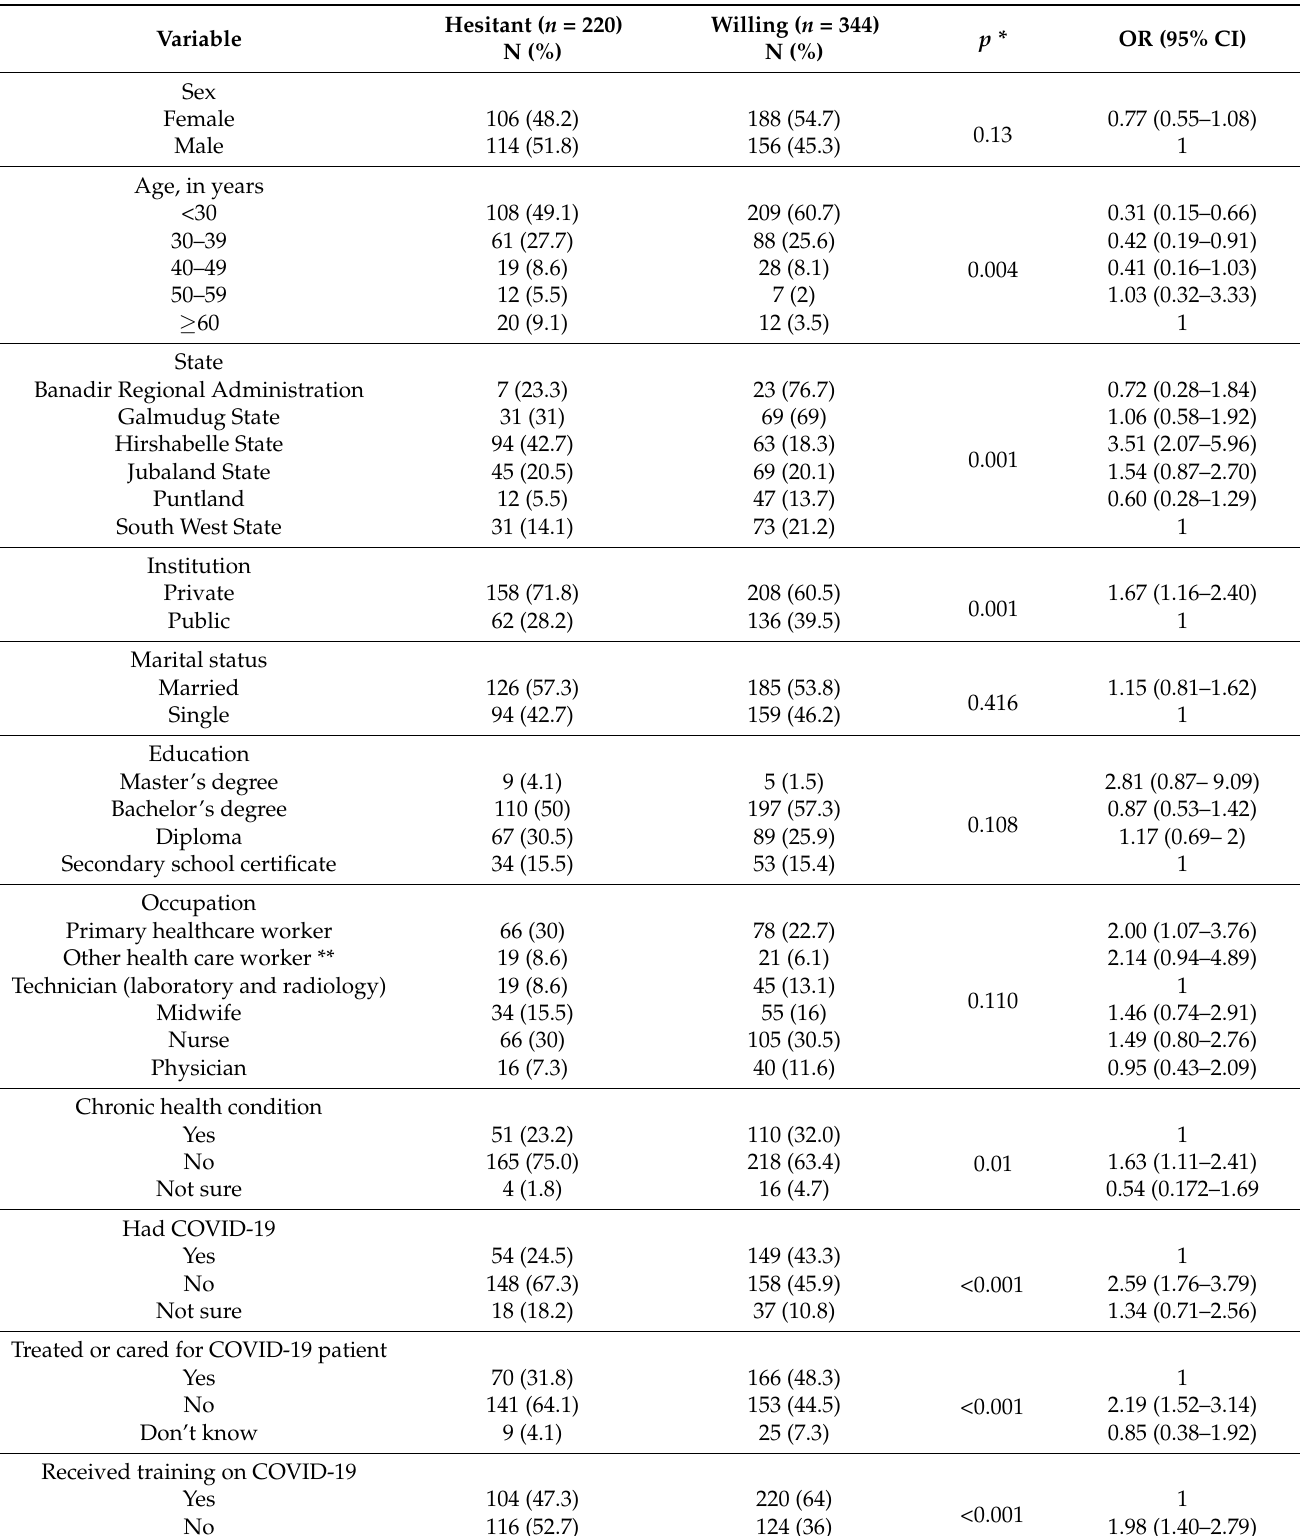
Table 4. Bivariate analysis of the hesitancy and willingness of unvaccinated Somali health workers to take the COVID-19